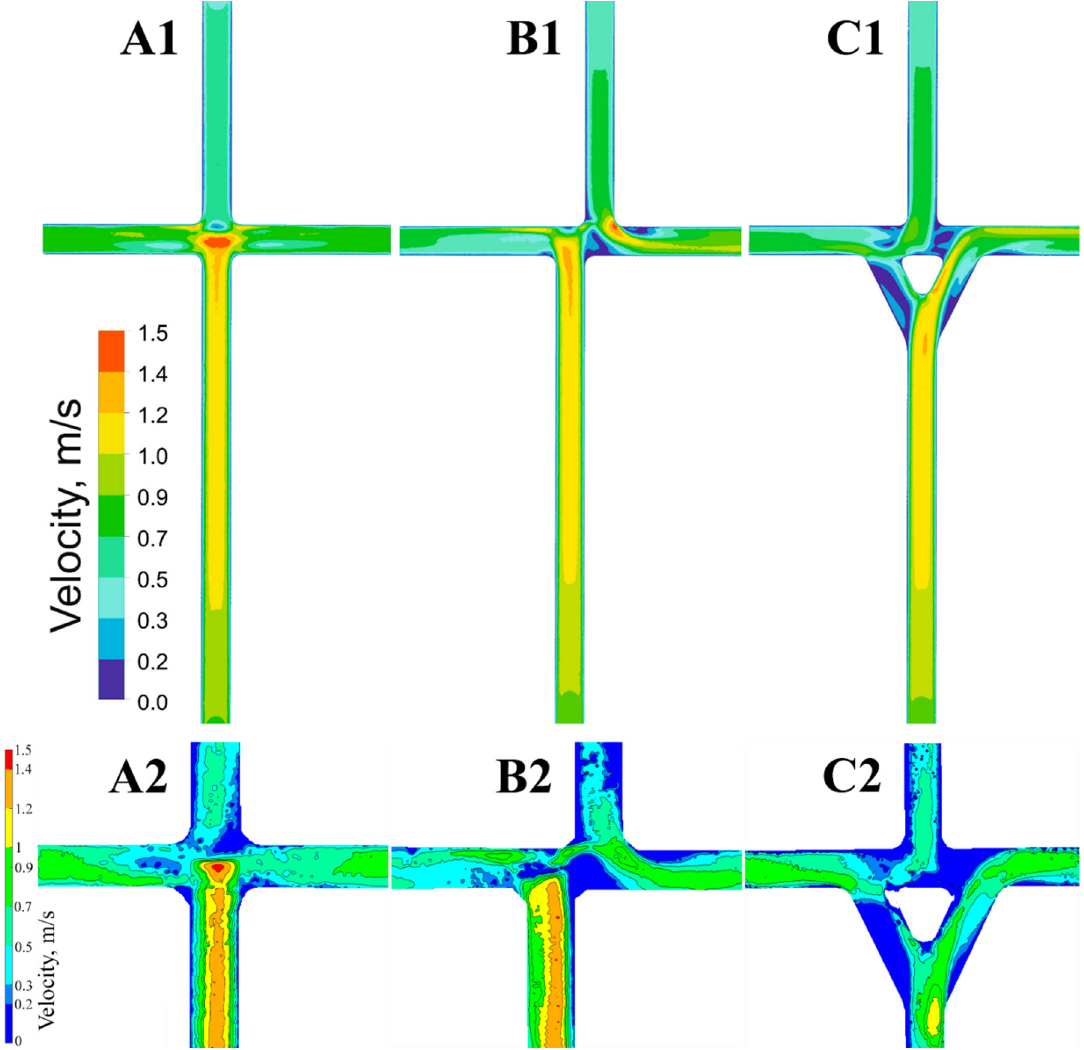
Figure 8. The contour plot of the flow velocity modulus distribution obtained by CFD simulation ( A1 , B1 , C1 ) and experimental data ( A2 , B2 , C2 ). The contour plot shows areas where the flow reaches maximum speed and places where the speed values are minimal.